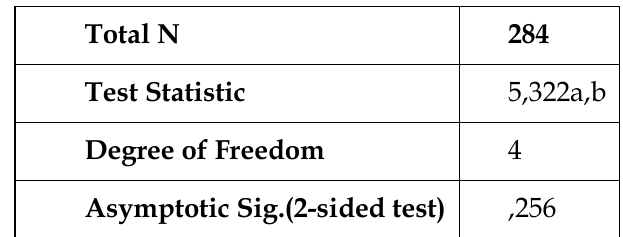
The test shows no significant differences across samples. Despite a lower mean rank for category ‘Other’ and higher for category